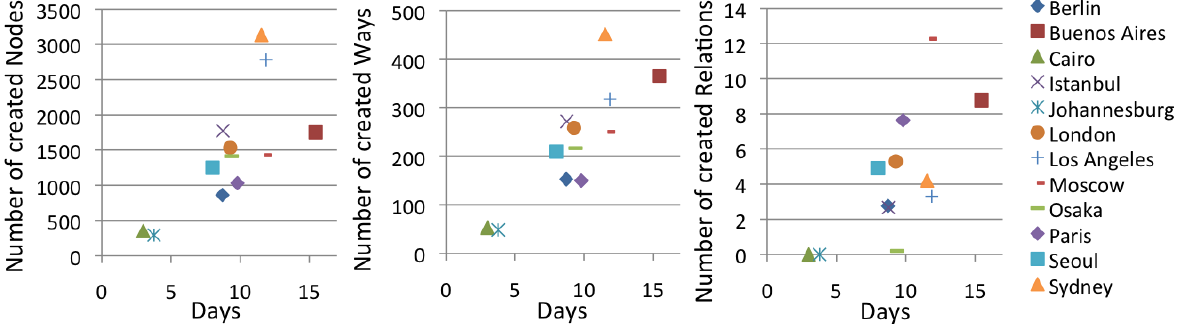
Figure 8. Average Senior Mapper Activity Timeframe and Contributions per Urban Area (Aug.–Oct.